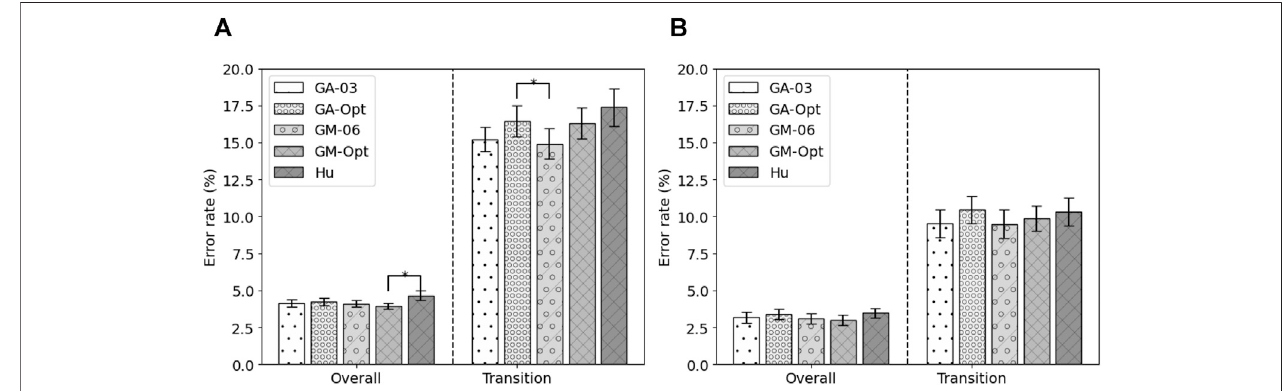
FIGURE 5 | Average error rate ( ± SEM) of the selected feature sets on 20% of the MyPredict dataset (A) and on the ENABL3S dataset (B) . A star indicates a signi fi cant difference.